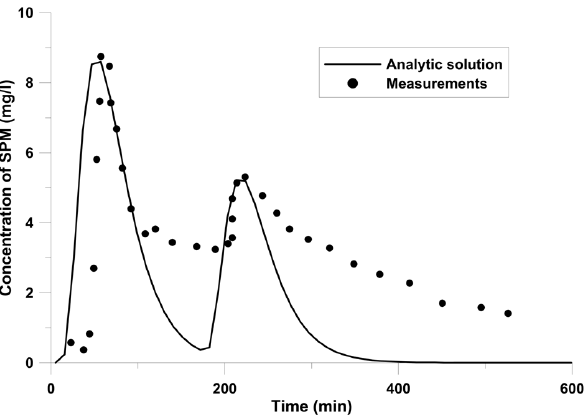
Figure 8. Calculated and measured variation in SPM concentration with time for the second Fig. 8. Calculated and measured variation in SPM concentration and third event in the Agnesberg landslide using a dispersion coefficient of D = 230 m 2 s -1 . with time for the second and third event in the Agnesberg landslide, using a dispersion coefficient of D =230m 2 s − 1 .